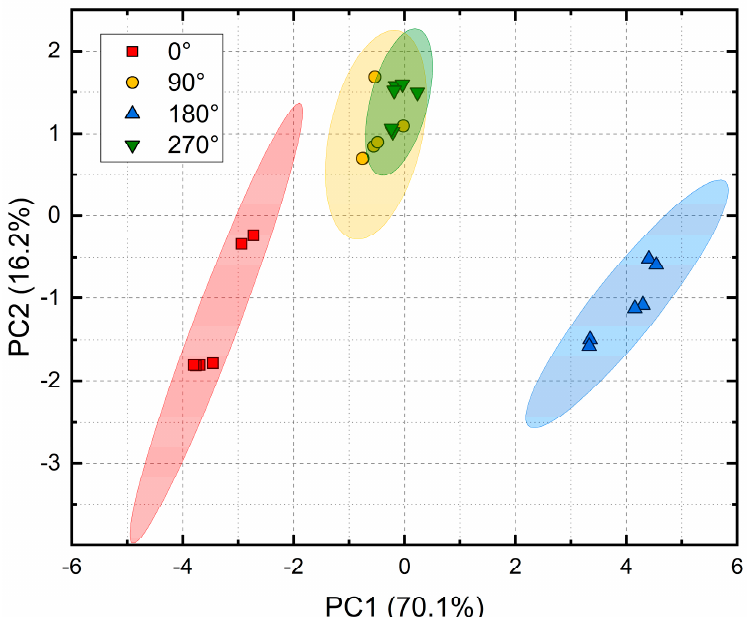
Figure 4. Biplot showing first and second principal components of the surface pressure parameters of the headform equipped with an ACH helmet. The scores plot illustrates the clustering in the space of two principal components, PC1 and PC2. The data were recorded at 70 kPa (~10 psi) nominal shock wave intensity, and the effect of the headform orientation is presented. The shaded areas surrounding the data points are 95% confidence ellipses. Table 1. The aggregate values (sum of averages) obtained from the quantification of the peak overpressure, rise time, duration, and impulse in the: 1) helmet orientation (ACH), and 2) helmet type (Ops-Core, Airframe, ECH) blast tests. The unprotected headform was used as a reference in the helmet type tests.